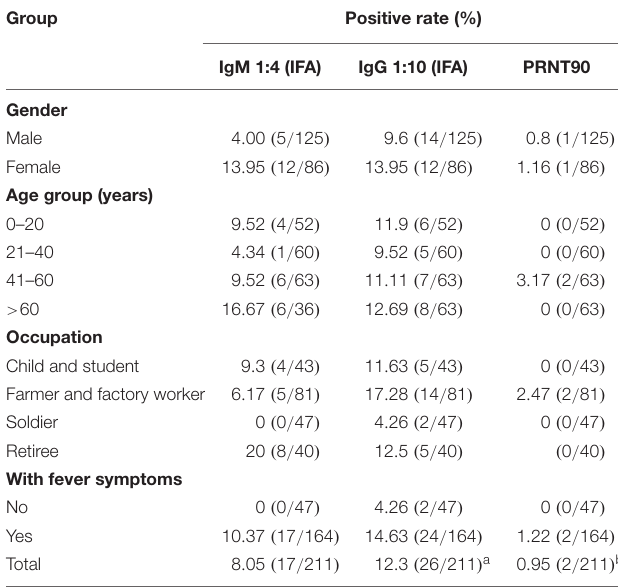
TABLE 1 | Study participant characteristics and human serum samples positive for EBIV.